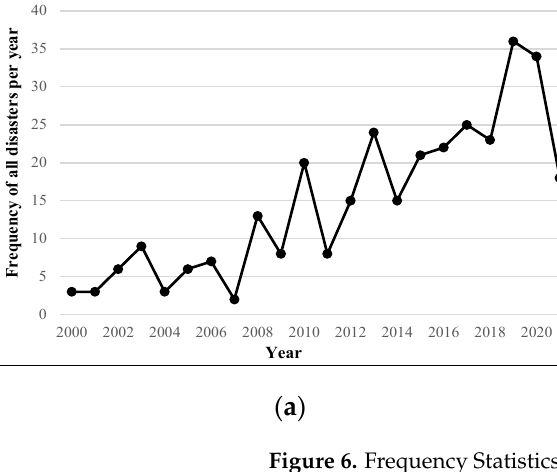
Figure 6. Frequency Statistics of Geological Hazards along the Railway: ( a ) Inter-Annual Frequency Statistics of Geological Hazards along the Railway; ( b ) Statistics on the Monthly Frequency of Geo- logical Hazards along the Railway.